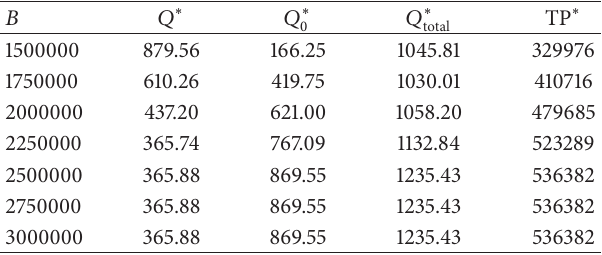
Table 5: Effect of changing 𝐵 on the optimal policy.